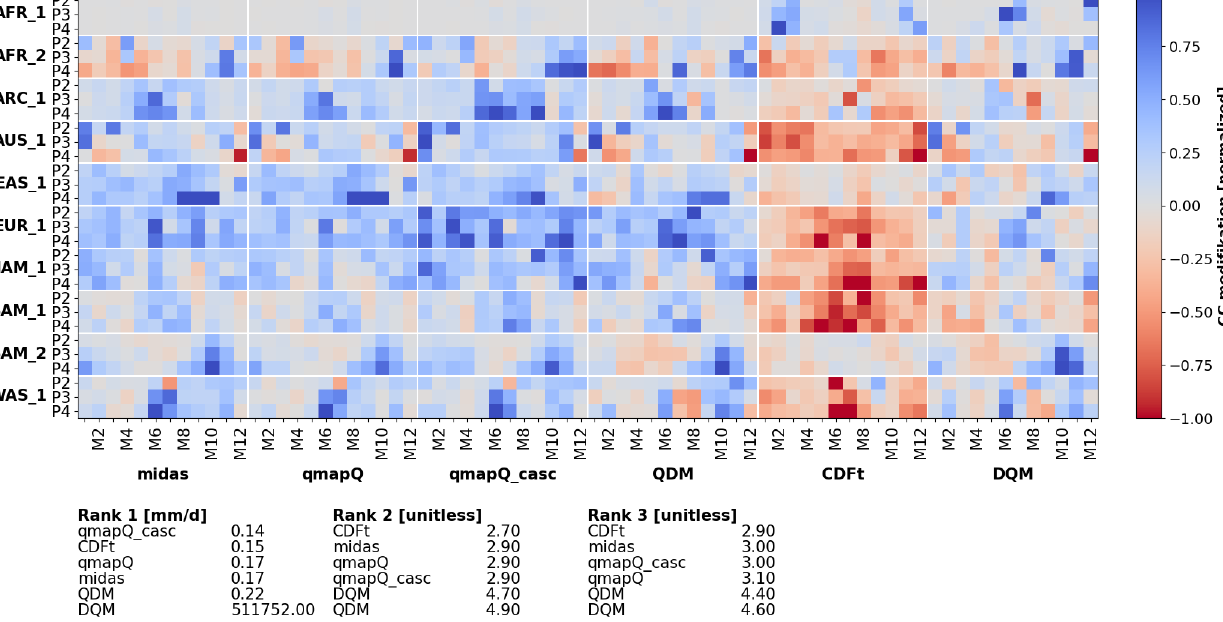
Geosci. Model Dev., 15, 6165–6180,